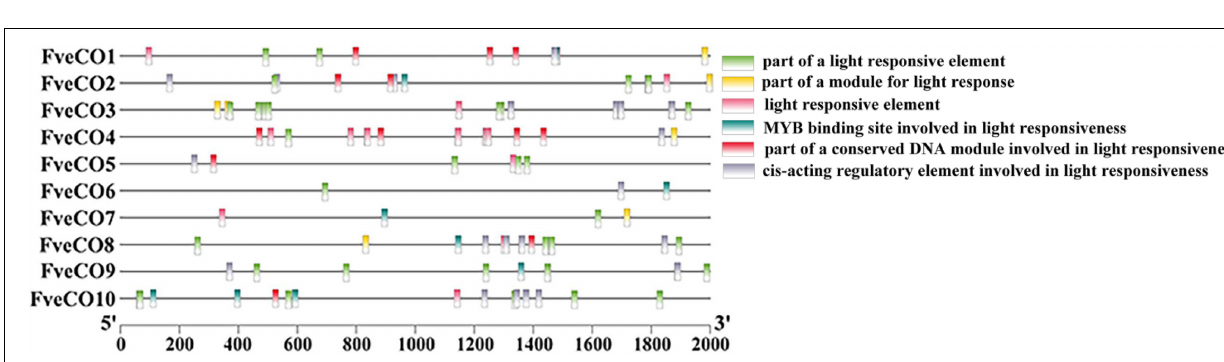
FIGURE 6 | Distribution of the major light-related cis -elements in the promoter sequences of 10 FveCO genes. Different cis -elements are represented by different symbols as